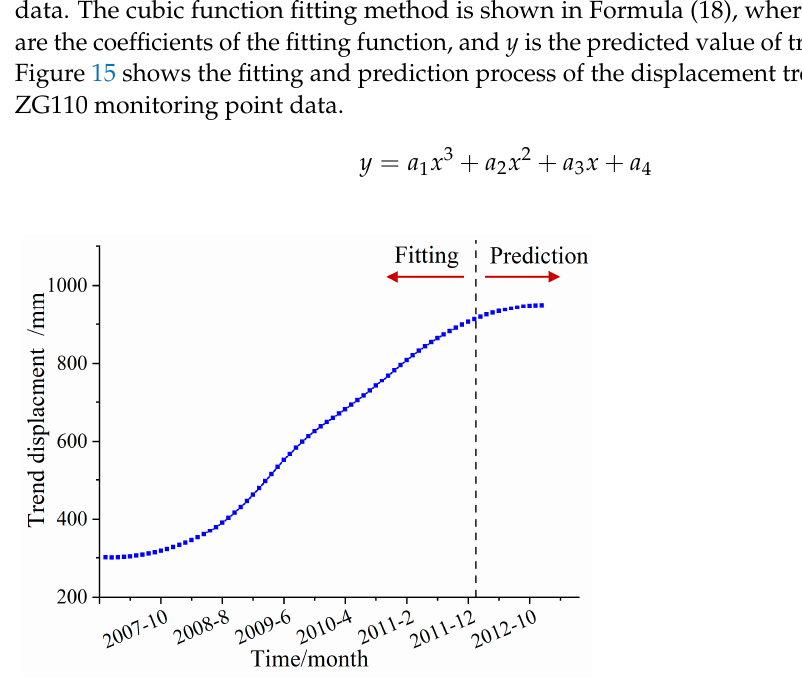
Figure 15. Fitting and prediction process for trend displacement on